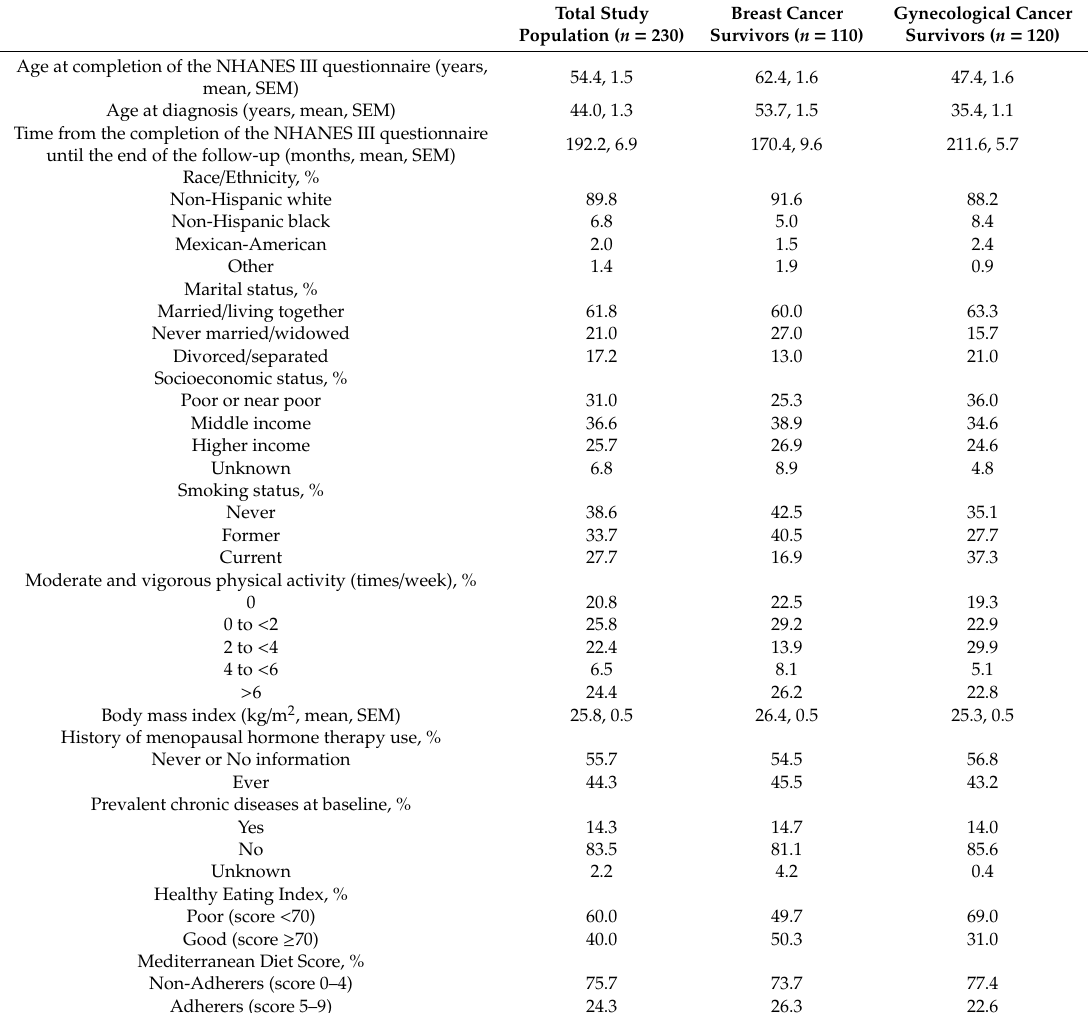
Table 1. Socioeconomic characteristics and participants’ behaviors at completion of the NHANES III questionnaire according to their cancer diagnosis and combined 1